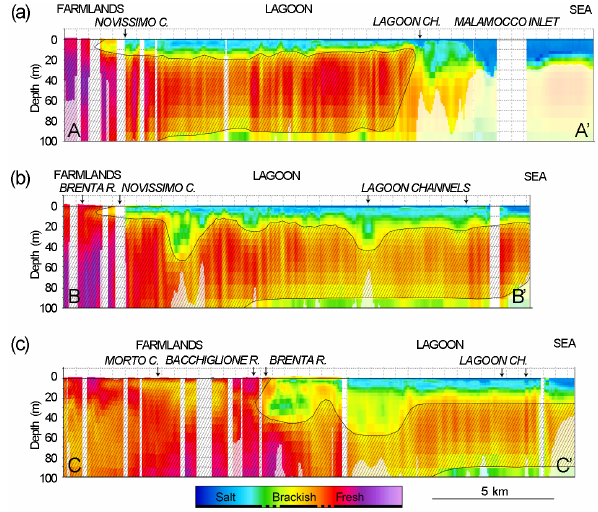
Figure 2. Multi-layer vertical resistivity sections obtained from the AEM survey (see section position in Fig. 1). The freshwaters are highlighted by a black oblique hatching.